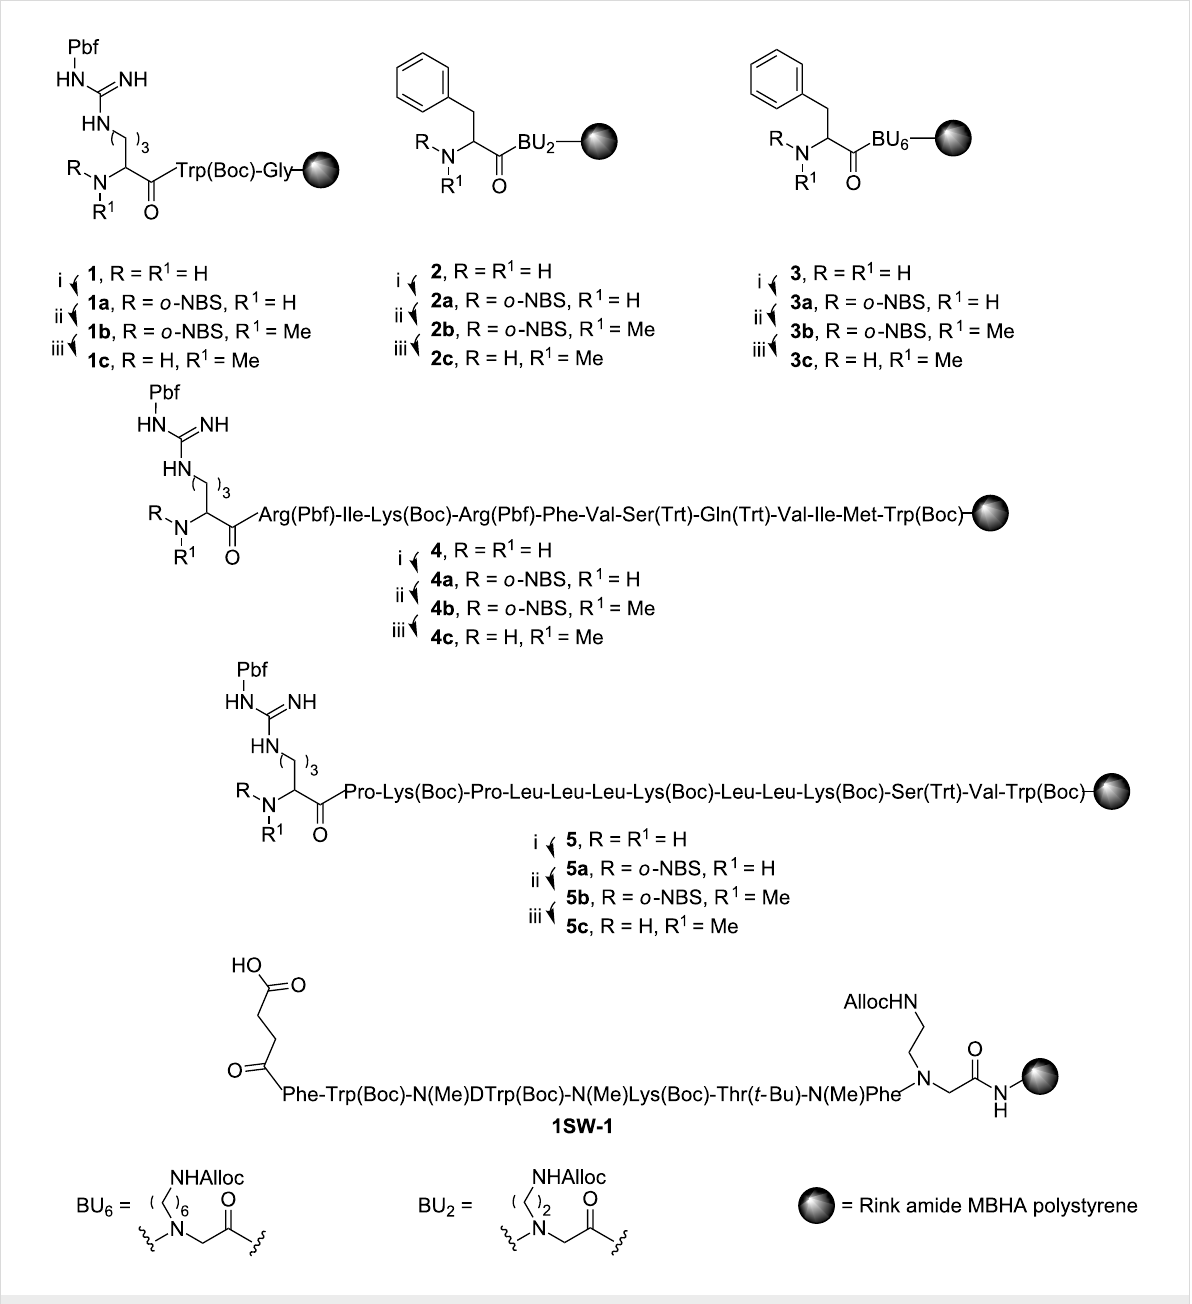
Figure 2: Motifs 1–5 were used as models for the optimization of the N -methylation process. i) Introduction of the o -NBS group to amines 1–5 using o -NBS-Cl. ii) Methylation of sulfonylamides 1a–5a using (Me) 2 SO 4 . iii) Removal of the o -NBS group using 2-mercaptoethanol to give methylated 1c–5c . 1SW-1 is a multiple sites N -methylated analogue of somatostatin.